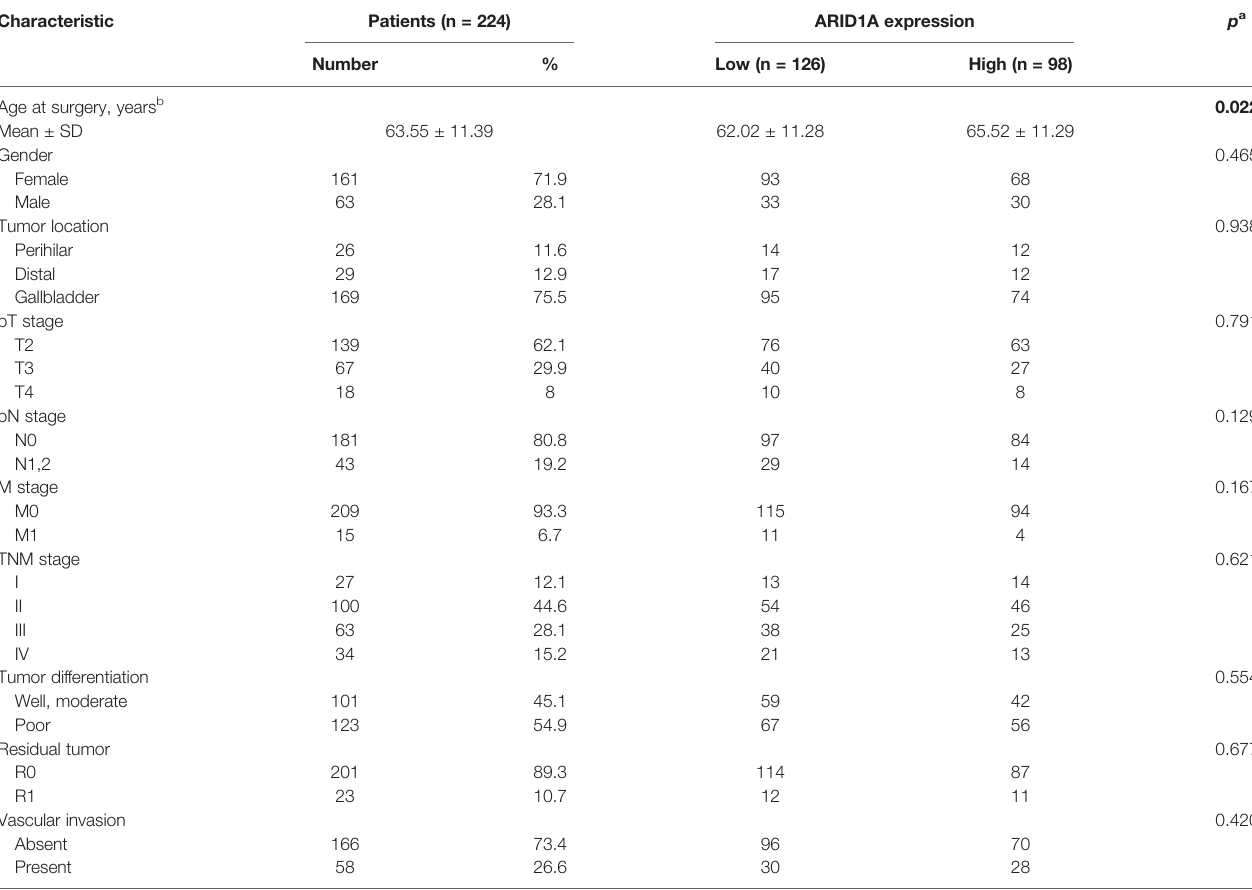
TABLE 1 | Correlations between ARID1A expression and patient characteristics. Characteristic Patients (n =